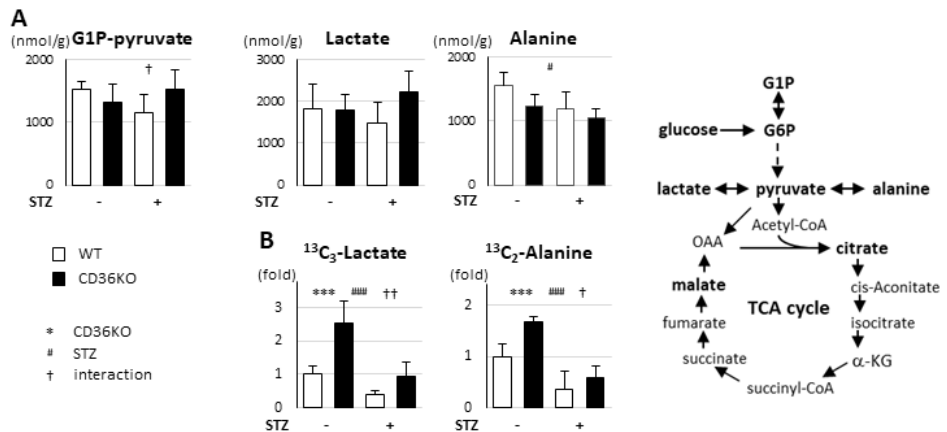
Figure 3. Glycolytic flux was markedly suppressed by STZ treatment. Hearts were isolated after a 6 h fast for metabolome analysis. ( A ) Metabolic profiling in glycolysis pathway. G1P-pyruvate, total metabolites from G1P to pyruvate in glycolysis ( n = 5–7). ( B ) Tracer study with 13 C 6 -glucose. After a 6 h fast, hearts were isolated 10 min after intraperitoneal injection of 13 C 6 -glucose ( n = 5–7). G1P, glucose 1-phosphate; G6P, glucose 6-phosphate; α -KG, α -ketoglutarate; OAA, oxaloacetate. *** p < 0.001; main effect for genotype. # p < 0.05, ### p < 0.001; main effect for STZ treatment. † p < 0.05, †† p < 0.01; interaction between genotype and STZ treatment.